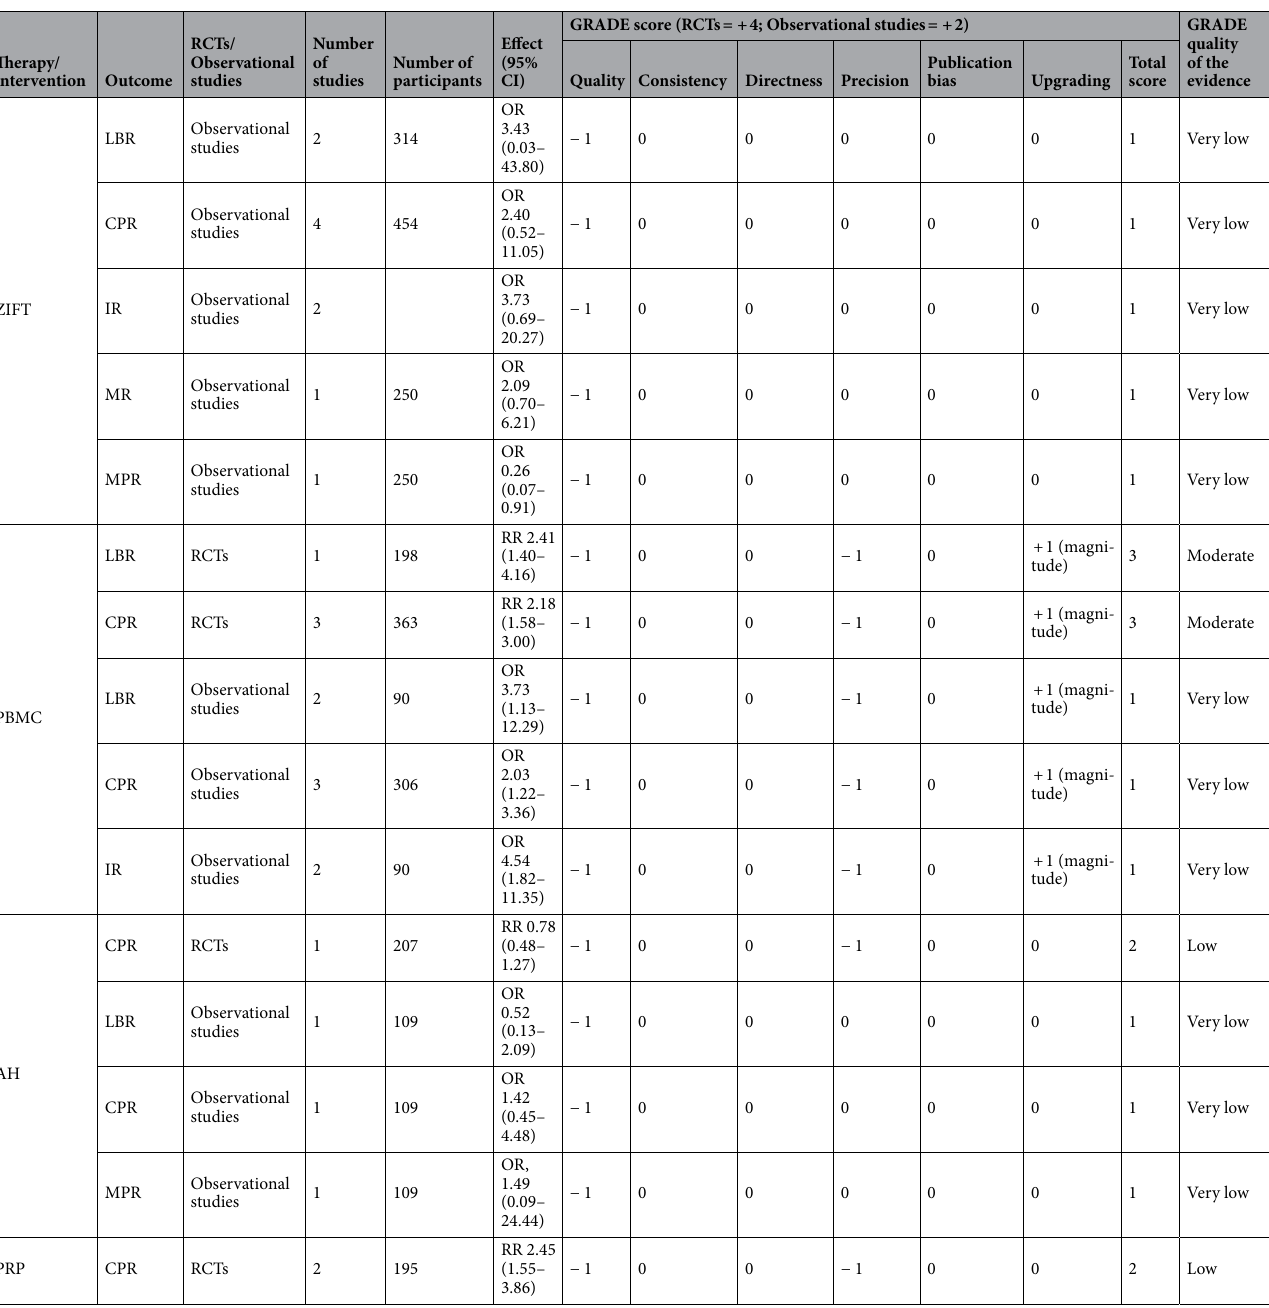
Table 4. Summary of findings and certainty of the evidence. GRADE Working Group grades of evidence. High quality: we are very confident that the true effect lies close to that of the estimate of the effect. Moderate quality: we are moderately confident in the effect estimate: the true effect is likely to be close to the estimate of the effect, but there is a possibility that it is substantially different. Low quality: our confidence in the effect estimate is limited: the true effect may be substantially different from the estimate of the effect. Very low quality: we have very little confidence in the effect estimate: the true effect is likely to be substantially different from the estimate of effect. RCT randomized clinical trial, G-CSF granulocyte-colony stimulating factor, LMWH low molecular weight heparin, PBMC peripheral blood mononuclear cells, AH assisted hatching, PGT- A preimplantation genetic testing for aneuploidy, IVIG intravenous immunoglobulin, PRP platelet rich plasma, hCG human chorionic gonadotropin, ZIFT zygote intrafallopian transfer, IR implantation rate, CPR